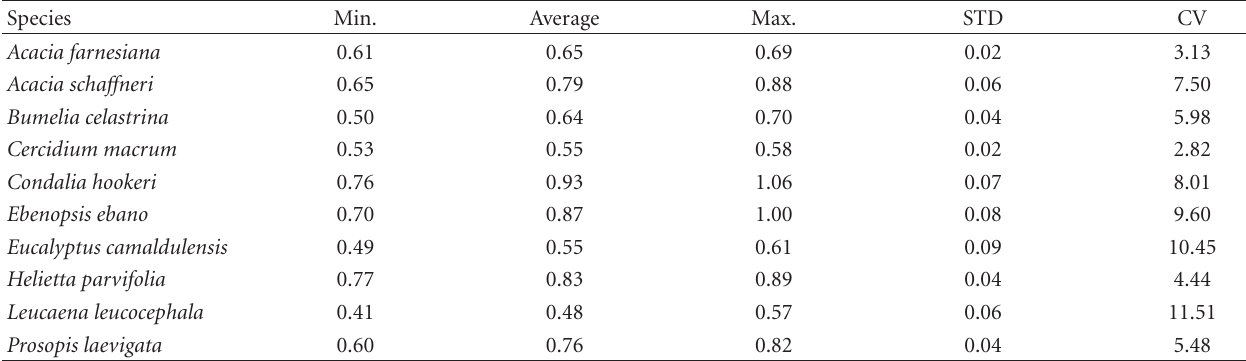
Table 4: Physical properties (density g cm − 3 ) of ten timber species of northeastern